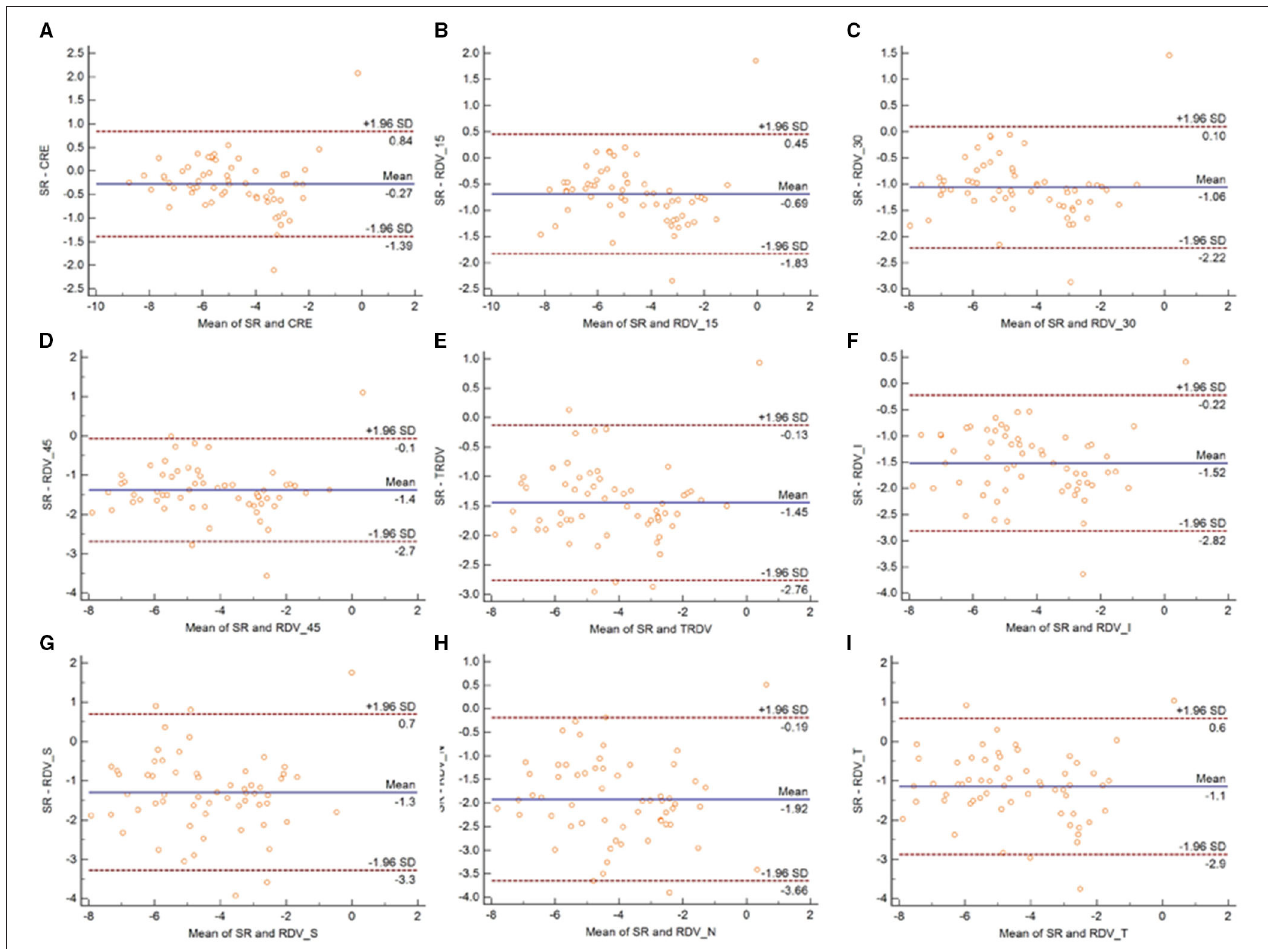
FIGURE 6 | Bland–Altman plots between OR and CRE (A) , RDV-15 (B) , RDV-30 (C) , RDV-45 (D) , TRVD (E) , RDV-I (F) , RDV-S (G) , RDV-N (H) , and RDV-T (I) in cycloplegia eyes. The solid line shows the mean difference (bias), and the upper and lower lines represent 95% limits of